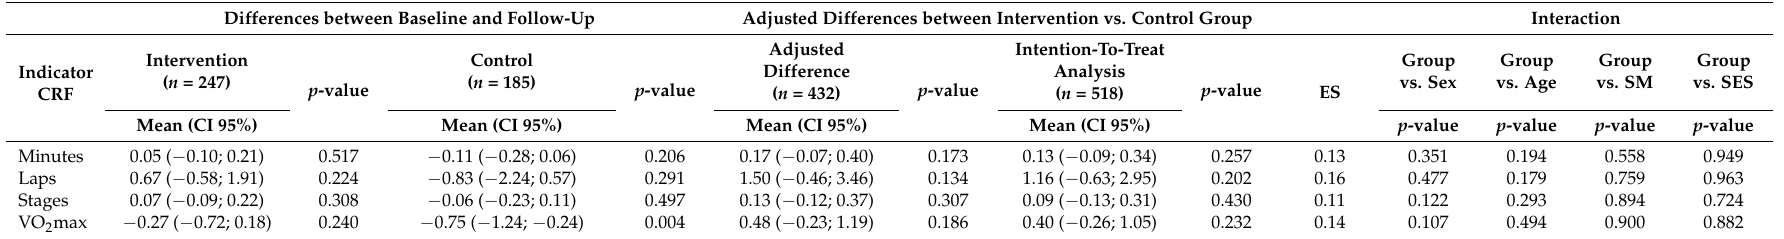
Table 3. Effect of “ MEXA-SE ” intervention on cardiorespiratory fitness (CRF) among Brazilian students. Florianopolis, SC, Brazil, 2015. Differences between Baseline and